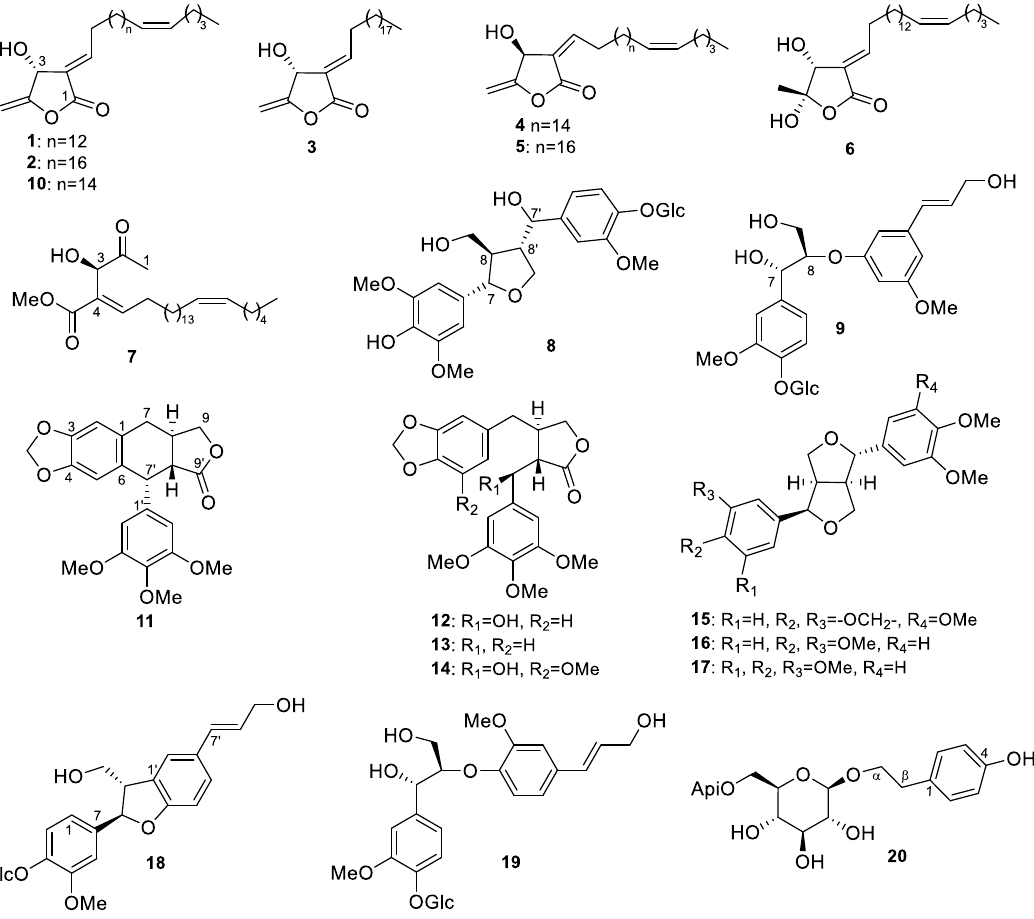
Figure 1. Isolated compounds ( 1 − 20 ) from H. nymphaeifolia .